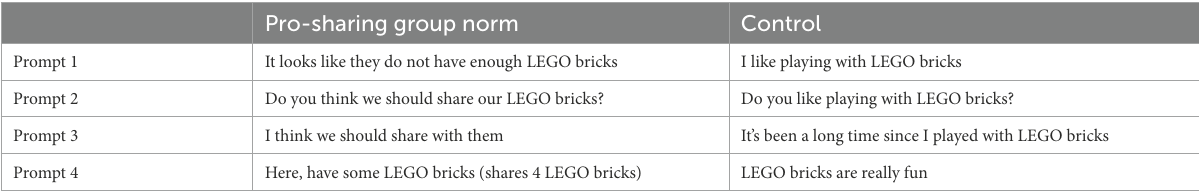
TABLE 4 Script for the confederate across both conditions for Study